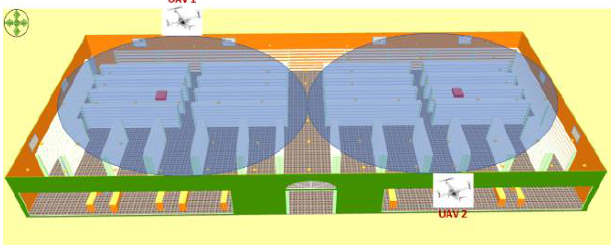
Figure 3 . Aerial map of the UAVs on the top layer around the trade centre